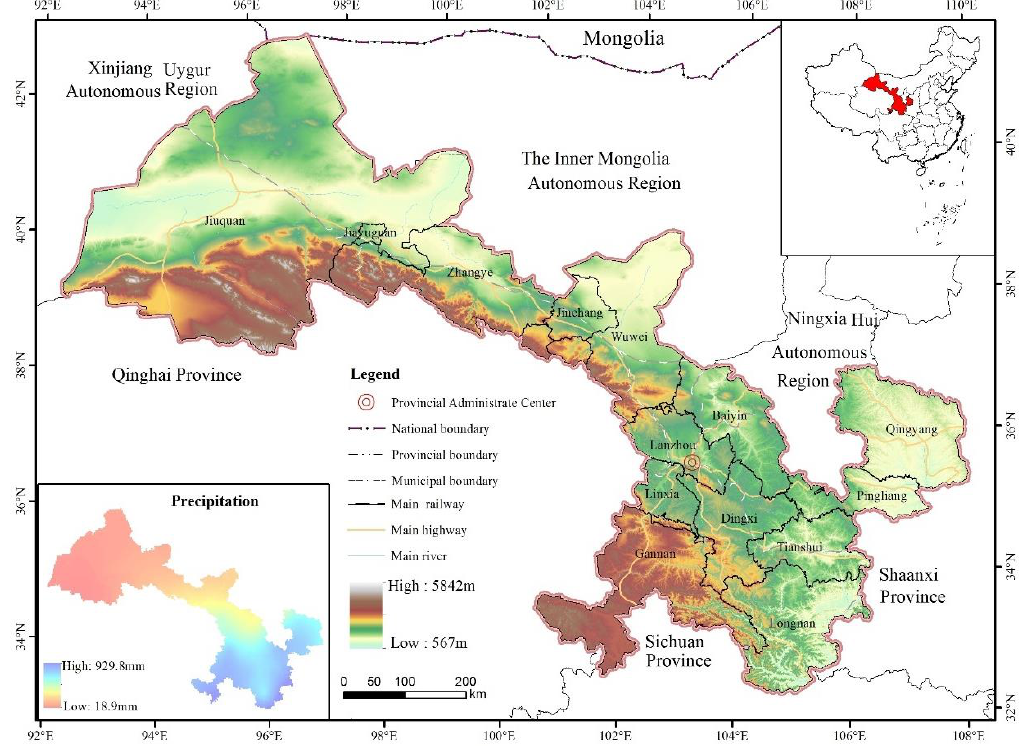
Figure 1. Location map of Gansu Province.